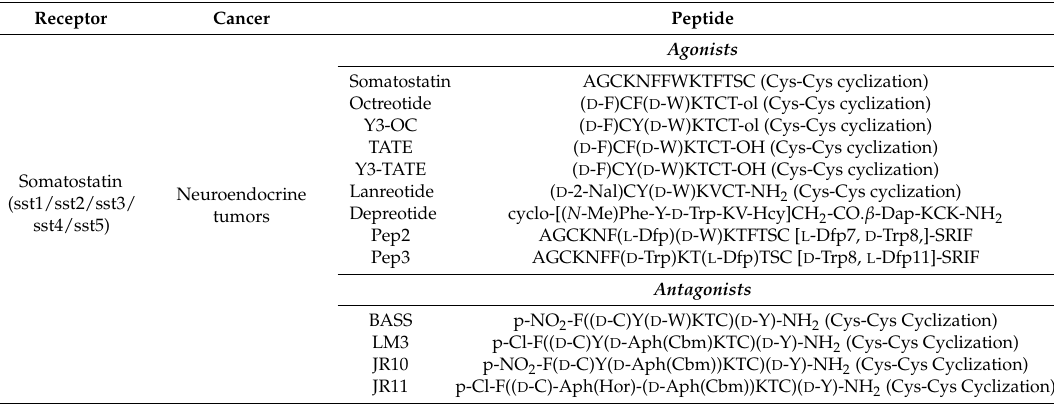
Figure 1. Schematic view of main chemical modifications ( D -amino acids, Glycosylation, PEGylation, etc.) introduced in peptide-based radiopharmaceuticals designed for imaging or radiotherapy. The modified peptide moiety, covalently bounded to the chelator through a linker inserted as spacer, acts as carrier to specific receptor. ( A ) Linear targeting peptide; ( B ) Multimeric targeting peptide; ( C ) Cyclic peptide. Table 1. Chemical composition of peptide-based radiopharmaceuticals.